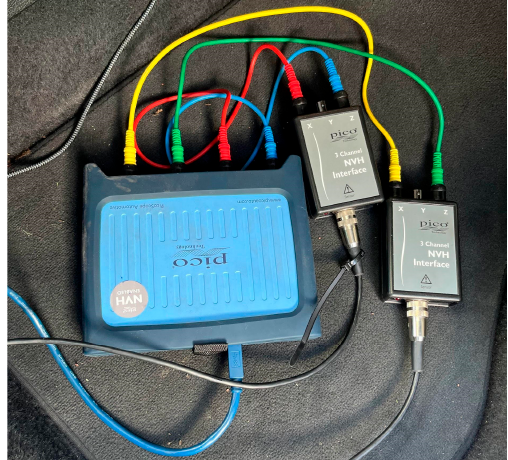
Figure 4. The measurement system, including the attenuators and the